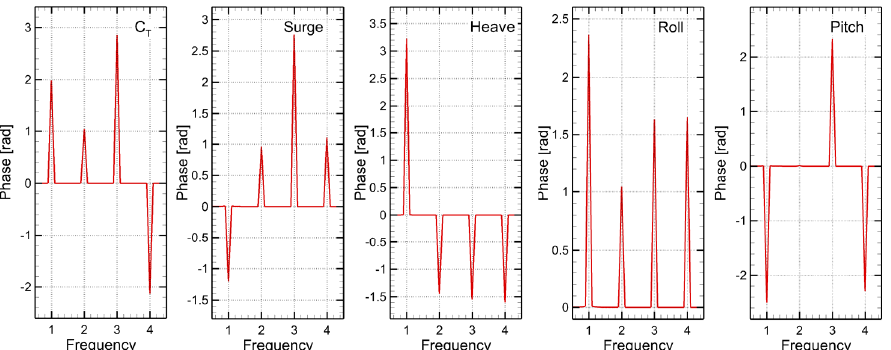
Figure 16. Harmonic phases of the total resistance coefficient ( C T ) , surge ( x ) , heave ( z ) , roll ( ϕ ) , and pitch ( θ ) for the bow waves FRxz ϕθ scenario.